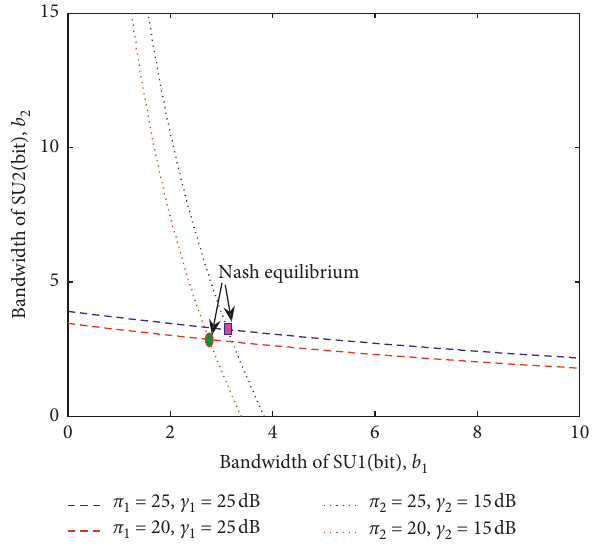
Figure 2: The best response function of the V-SU.